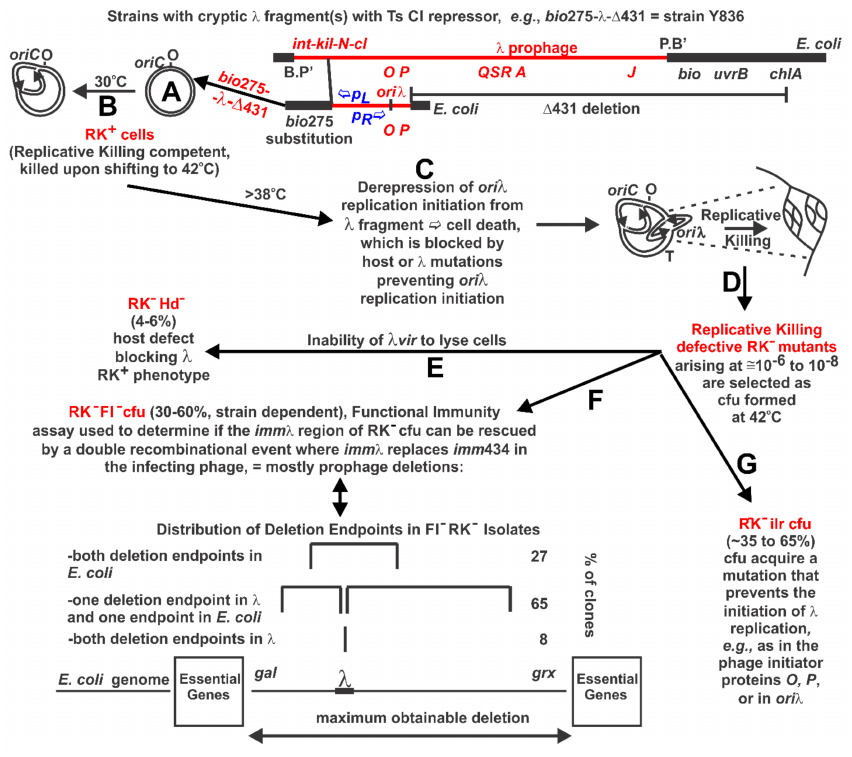
Figure 1. Replicative Killing, RK + phenotype and selection for RK − mutants. ( A ) Defective